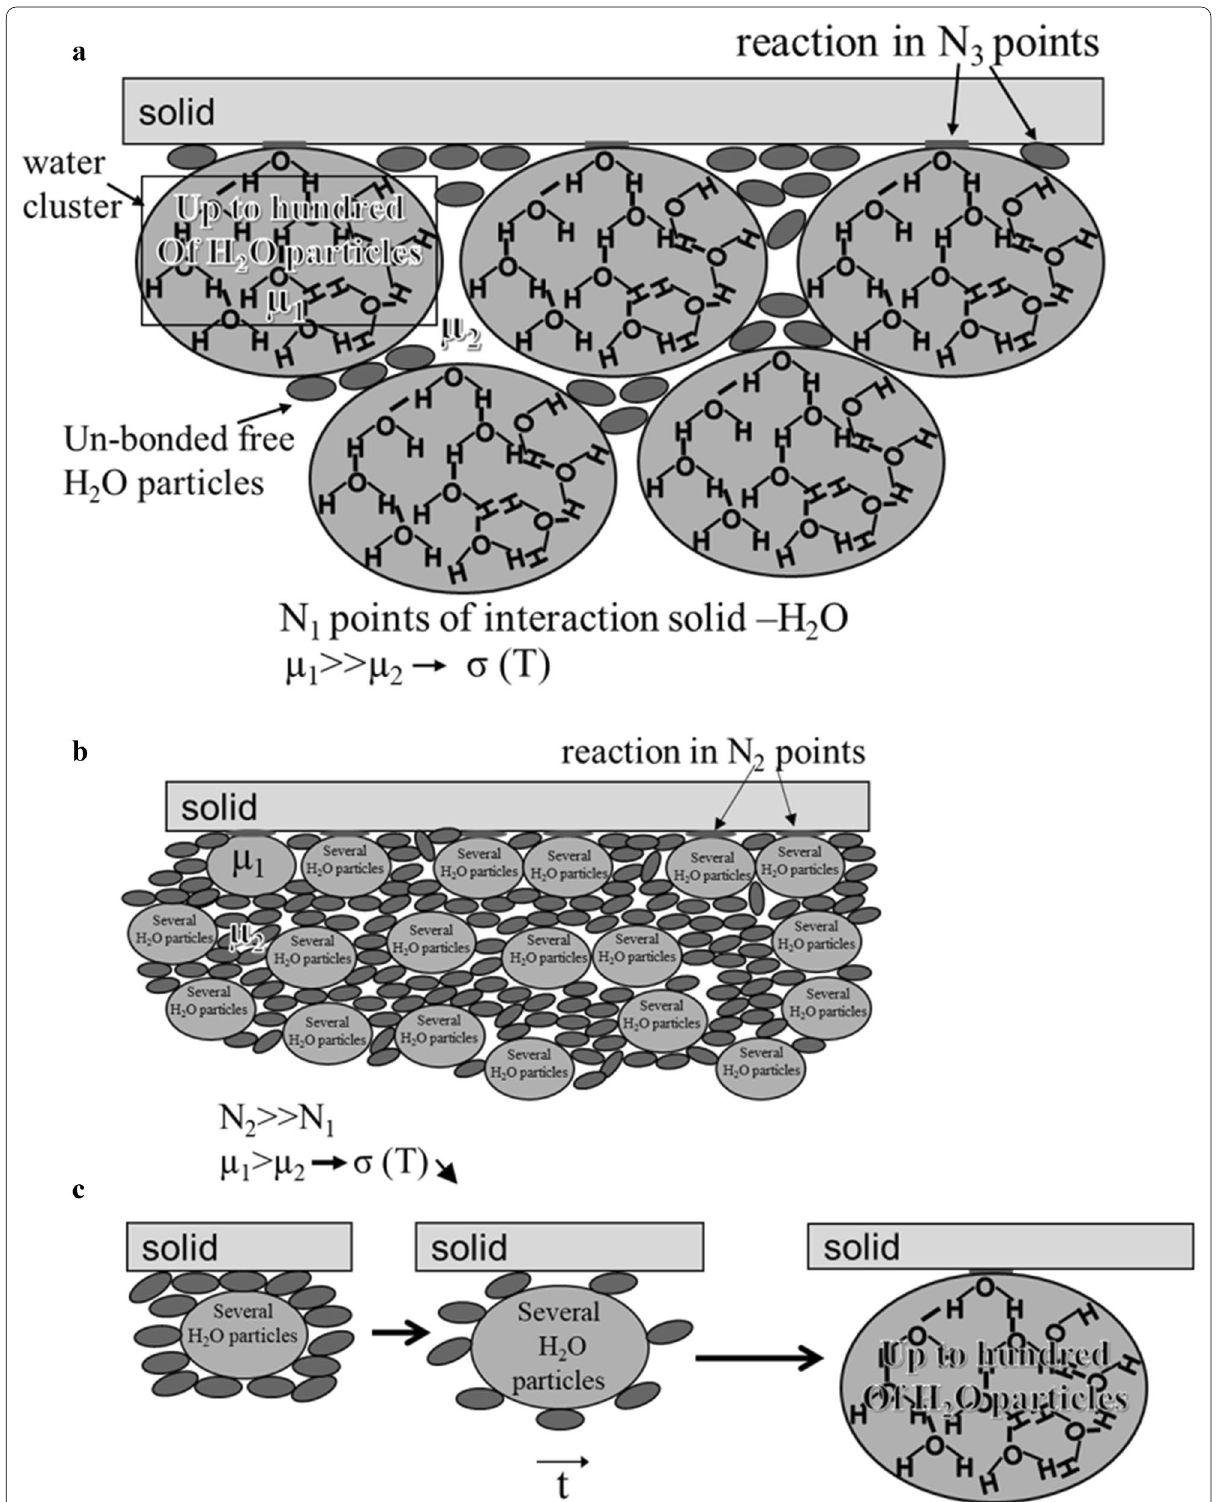
Fig. 15 A schematic model explaining the etch rate enhancement and its decay observed in an activated water by means of microwave irradiation. Structure of a natural water composed of clusters of water molecules, b activated water containing many unbonded free water molecules, and c time consuming rebuilding of water clusters [84], © 2004,